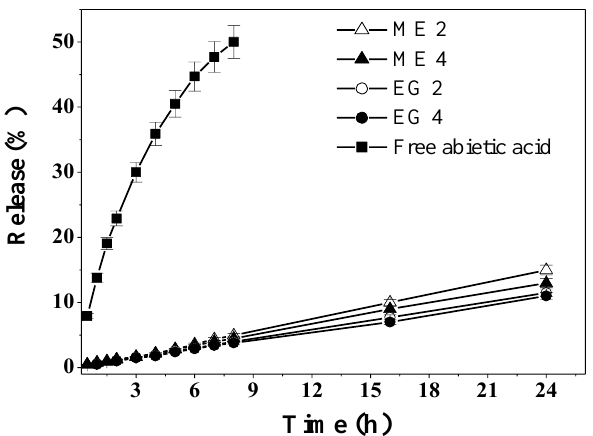
Figure 2. Release of free abietic acid and abietic acid formulated in microemulsions and emulgels. The drug concentration in samples is 0.5% wt., PBS:ethanol (1:1) medium, 34 °C.